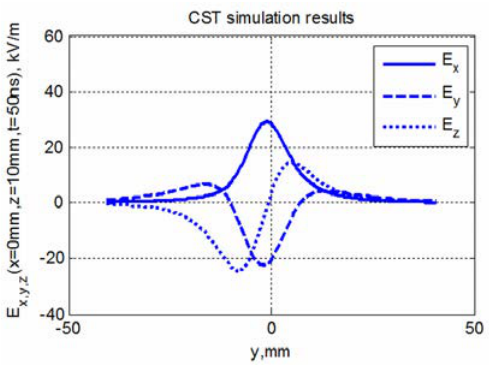
Figure 23: Simulated electric field components E x , E y and E z for the dipoles in Figure 21 along the line z = 10 mm and x = 0 and at the instant time t = 50